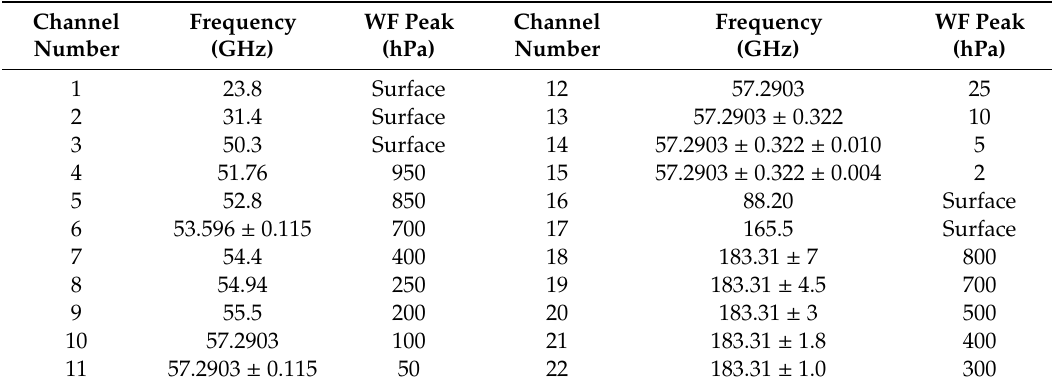
Table 1. Central frequency of each channel and its weighting function (WF) peak for the Advanced Technology Microwave Sounder